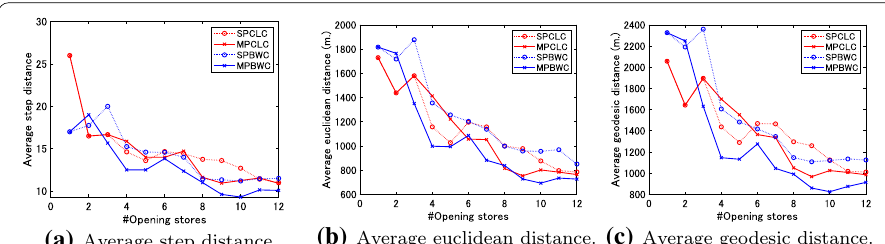
Fig. 5 Average distance between actual and predicted locations (Naha): The red dotted, the red solid, the blue dotted, and the blue solid lines represent the average distances between predicted locations by SPCLC, MPCLC, SPBWC, and MPBWC, and the actual location. A small average distance means that the locations of the actual store and the predicted node are close to each other, which means that the prediction can be made accurately